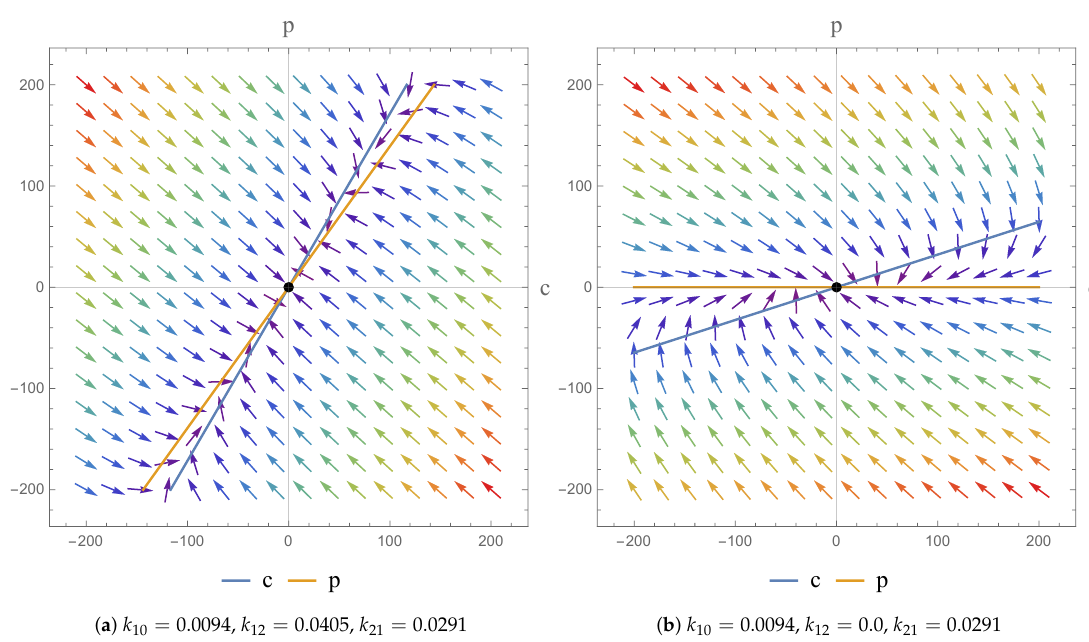
Figure 2. Phase portrait representing c ( t ) and p ( t ) . The arrows illustrates the trajectories of the